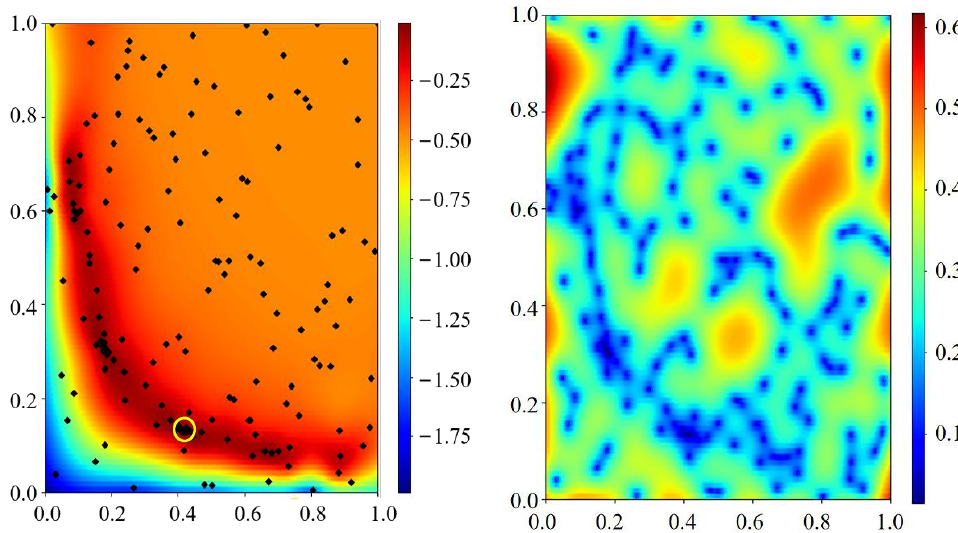
Figure 4. Two parameter optimization process of a and b in the Teng model. The horizontal axis is the a / b with normalization, and the longitudinal axis is the b with normalization.